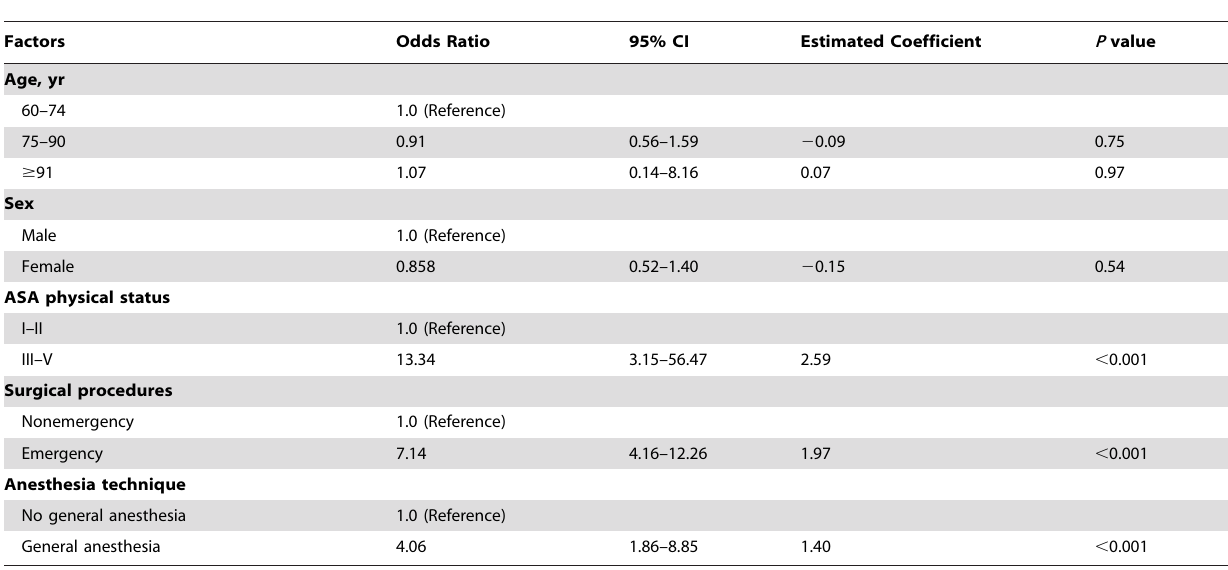
Table 5. Factors associated with intraoperative mortality in older patients.